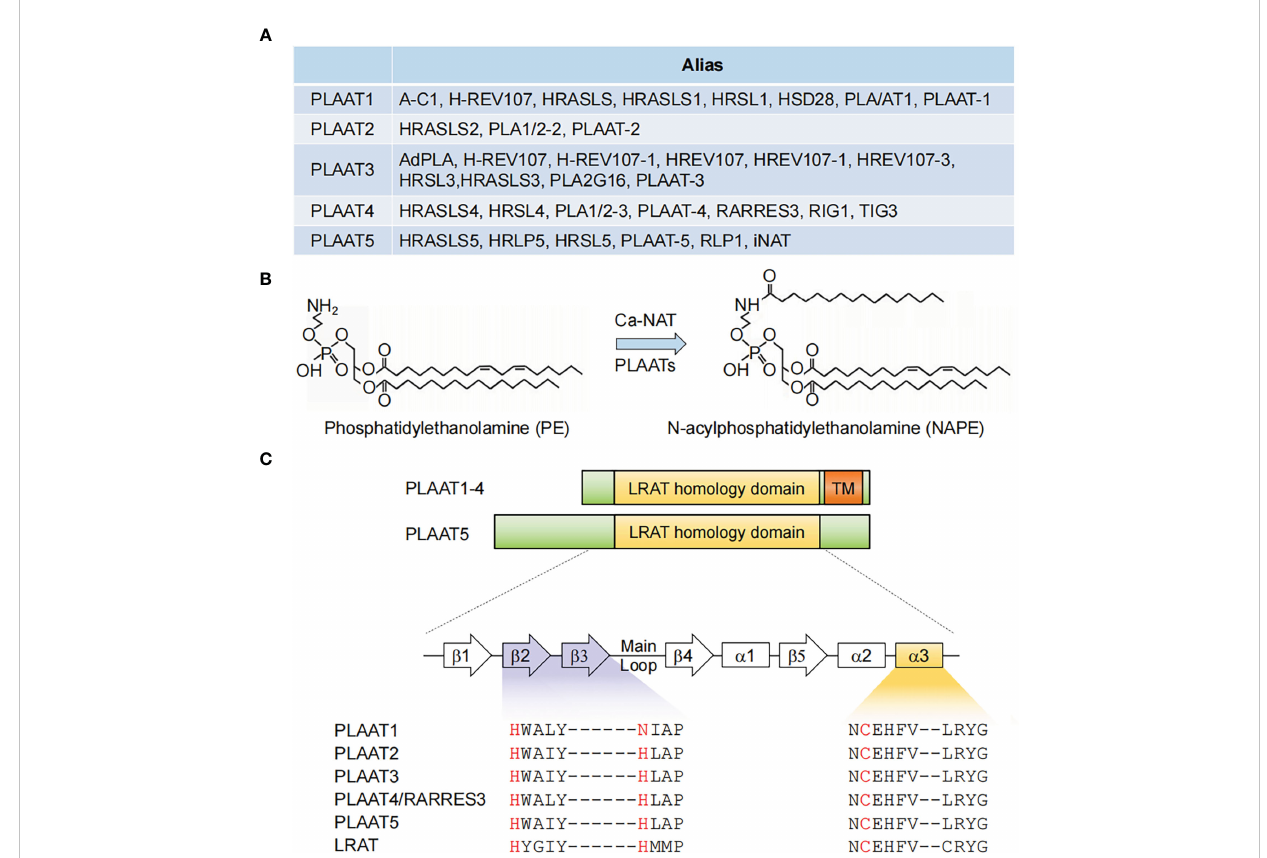
FIGURE 1 PLAAT family enzymes. (A) Gene names and aliases for all fi ve PLAAT family proteins. (B) Illustration of an example of phospholipid metabolism reaction catalyzed by PLAAT family proteins. (C) Alignment of the structural domains of PLAAT family enzymes. The lecithin retinol acyltransferase (LRAT) homology and transmembrane (TM) domains are shown. The enzymatic activity of PLAAT proteins involves a cysteine-histidine-histidine triad, with the cysteine from a highly conserved ‘ NCEHFV ’ motif being the catalytically active site. a 1 − 3, a helices 1-3; b 1 − 5, b sheets